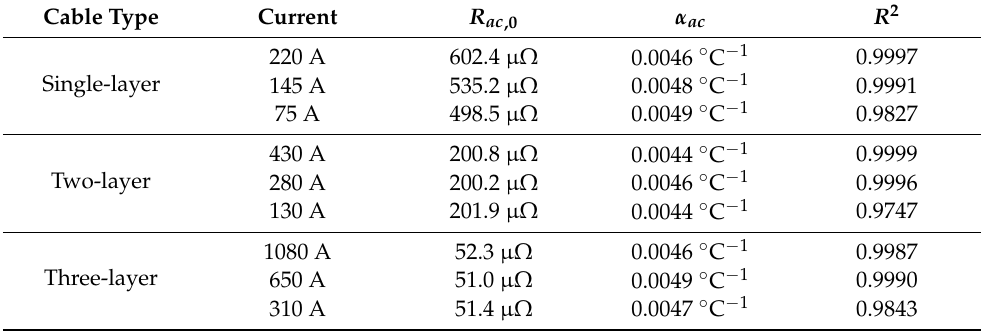
Table 2. Regression coefficients of